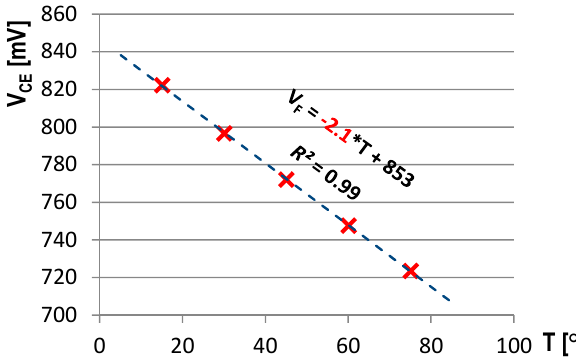
Figure 12. Calibration result: forward voltage of a power IGBT at a I M = 100 mA measurement current. The test started with a longer equalization period until the V CE voltage at constant I H stabilized.